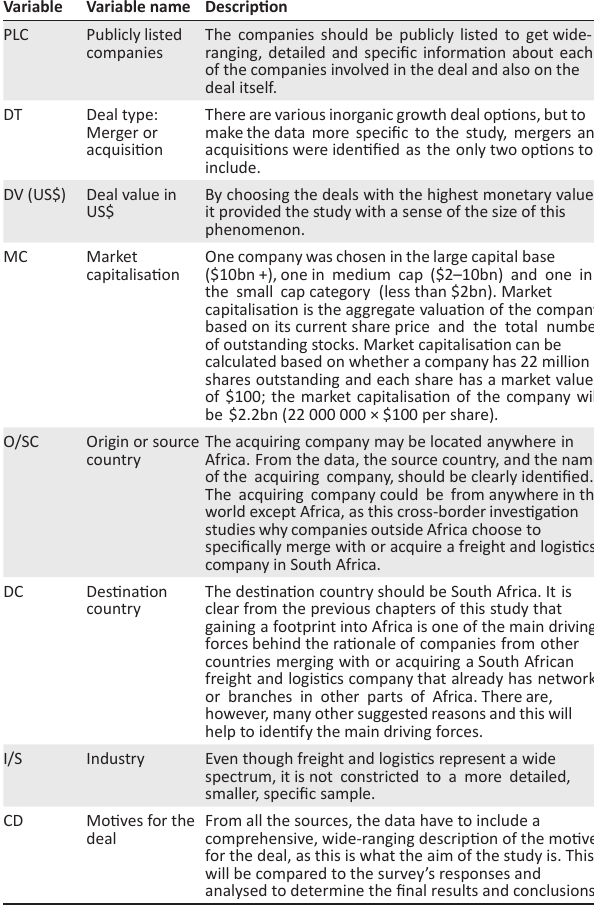
TABLE 1: Specific variables for the